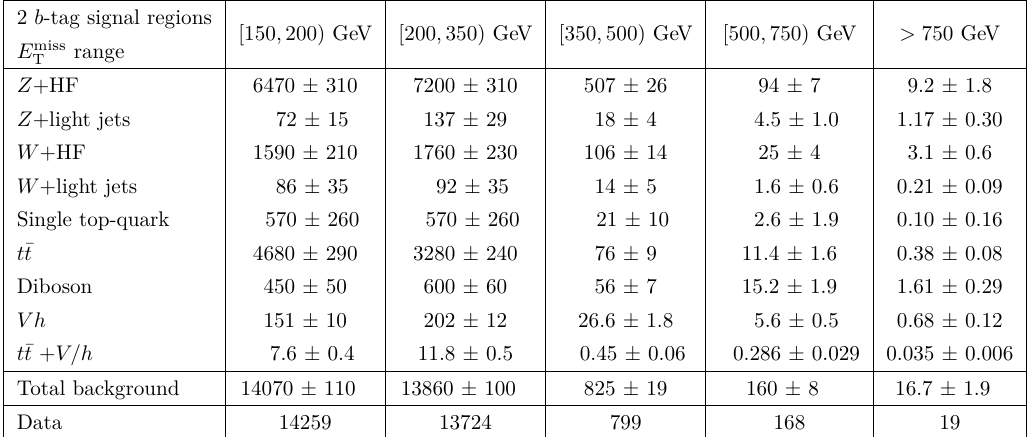
Table 4. Background yields in comparison with data in the 2 b -tag signal regions for different E miss ranges after a background-only fit to data. Statistical and systematic uncertainties are reported together.